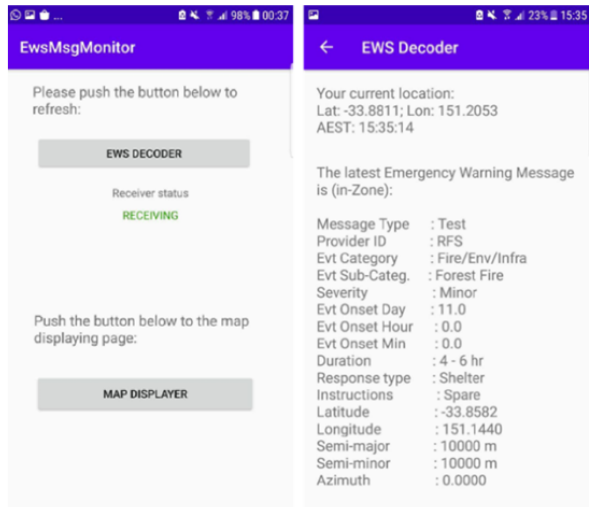
Figure 5. Screenshots from the EWS Android App